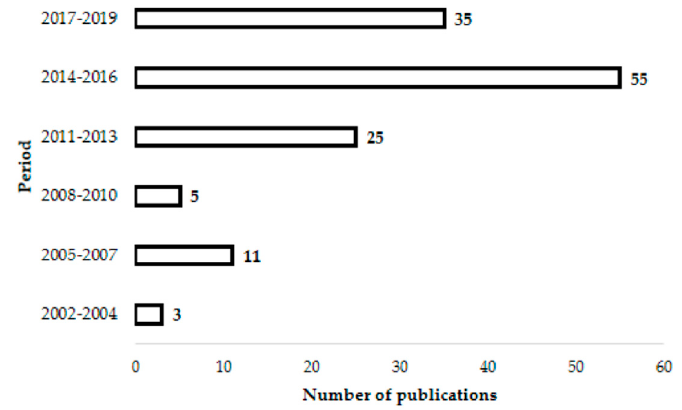
Figure 2. Variation in the number of publications dealing with the isolation and metabolic profile investigation of actinobacteria in Algeria based on data since 2002 to the present.